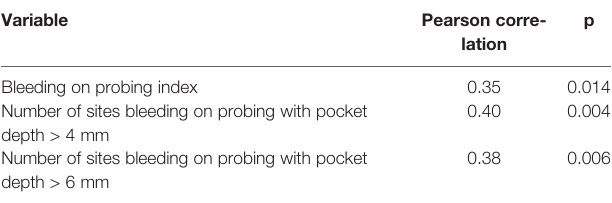
TABLE 1 | Multiple linear regression analysis using the log-transformed concentrations of pleckstrin as the dependent variable. R 2 = 0.38 (n=120). Variable B